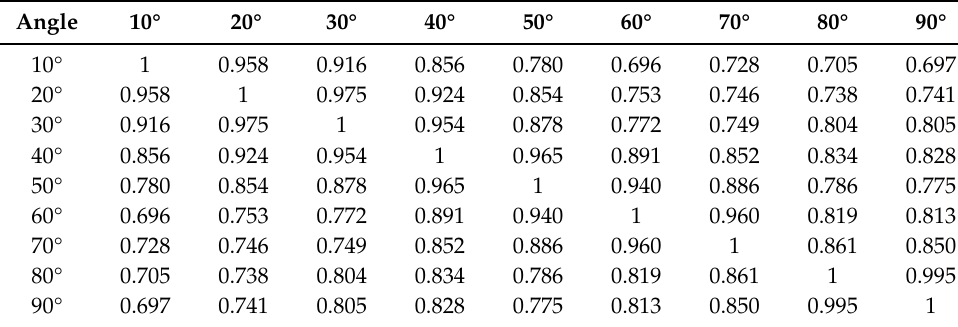
Table 1. Correlation matrix of H1